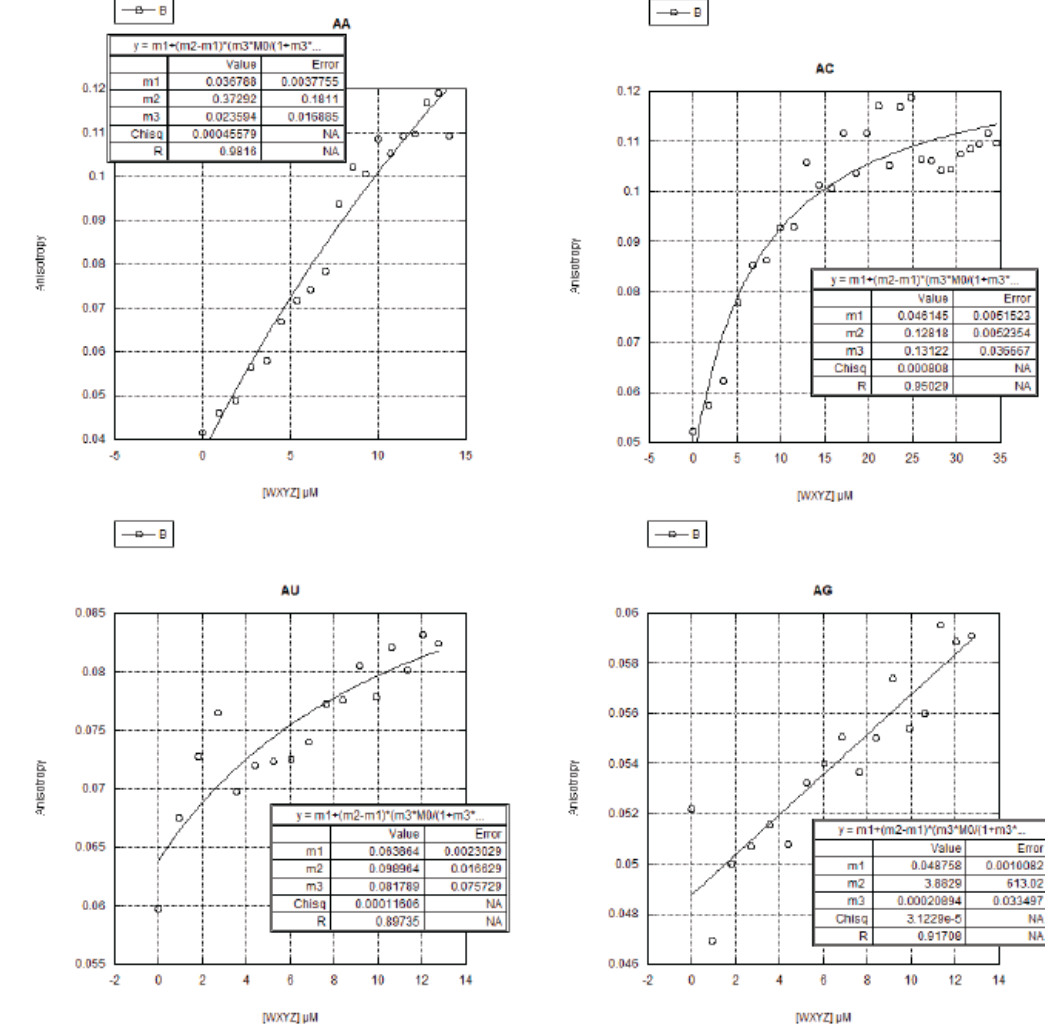
Figure A1. Raw anisotropy data for IGS-tag combinations where the middle nucleotide of the IGS is adenosine. All of these plots show effective saturation in polarization as RNA concentration increases.